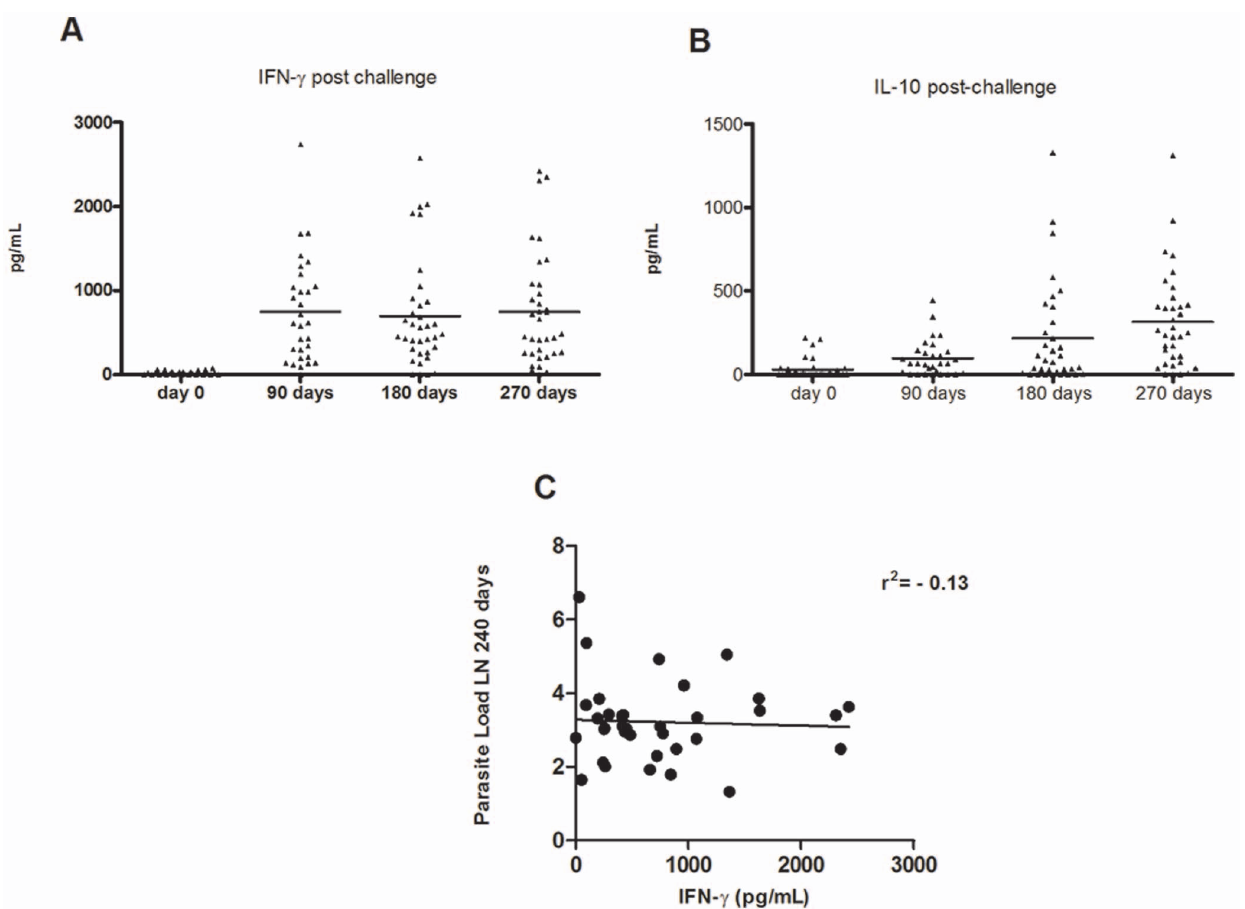
Figure 6. Levels of IFN- c and IL-10 in supernatants of PBMC from experimentally infected dogs. Dogs were infected with Leishmania infantum-chagasi plus five pairs of Lutzomyia longipalpis salivary glands. PBMC were obtained at days zero, 90, 180 and 270 post infection re- stimulated in vitro with Leishmania infantum-chagasi and the supernatant collected after 48 and 72 hours for determination of IFN- c (A) and IL-10 (B) by ELISA, respectively. (C) Spearman correlation between IFN- c levels and parasite load at 240 days after infection.